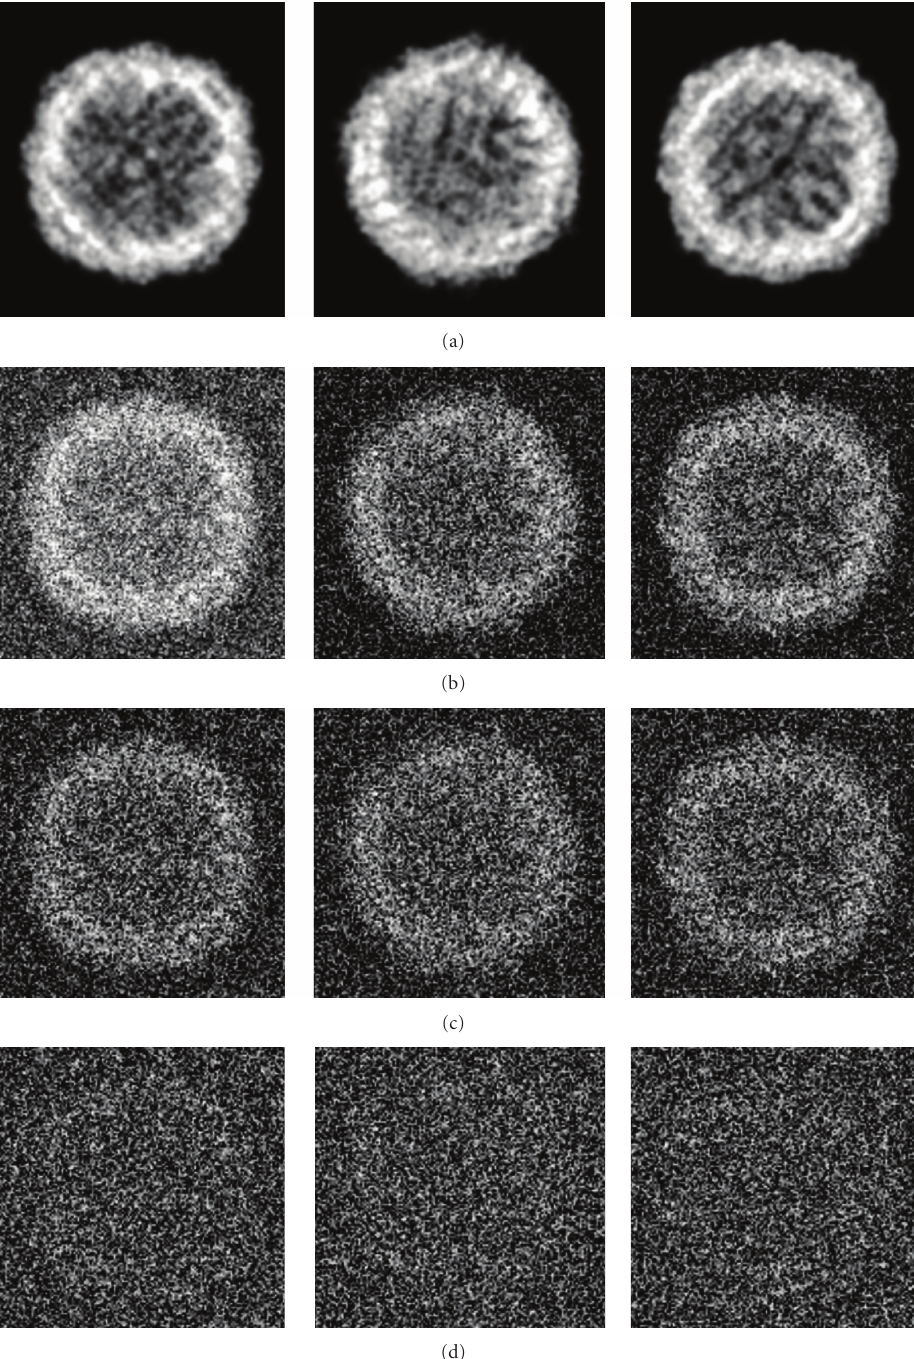
Figure 3: Three representative projection images of the erythrocyte L Ferritin model generated from PDB data. (a) Without noise, (b) with S/N = 0 . 8, (c) with S/N = 0 . 5, (d) with S/N = 0 . 1.